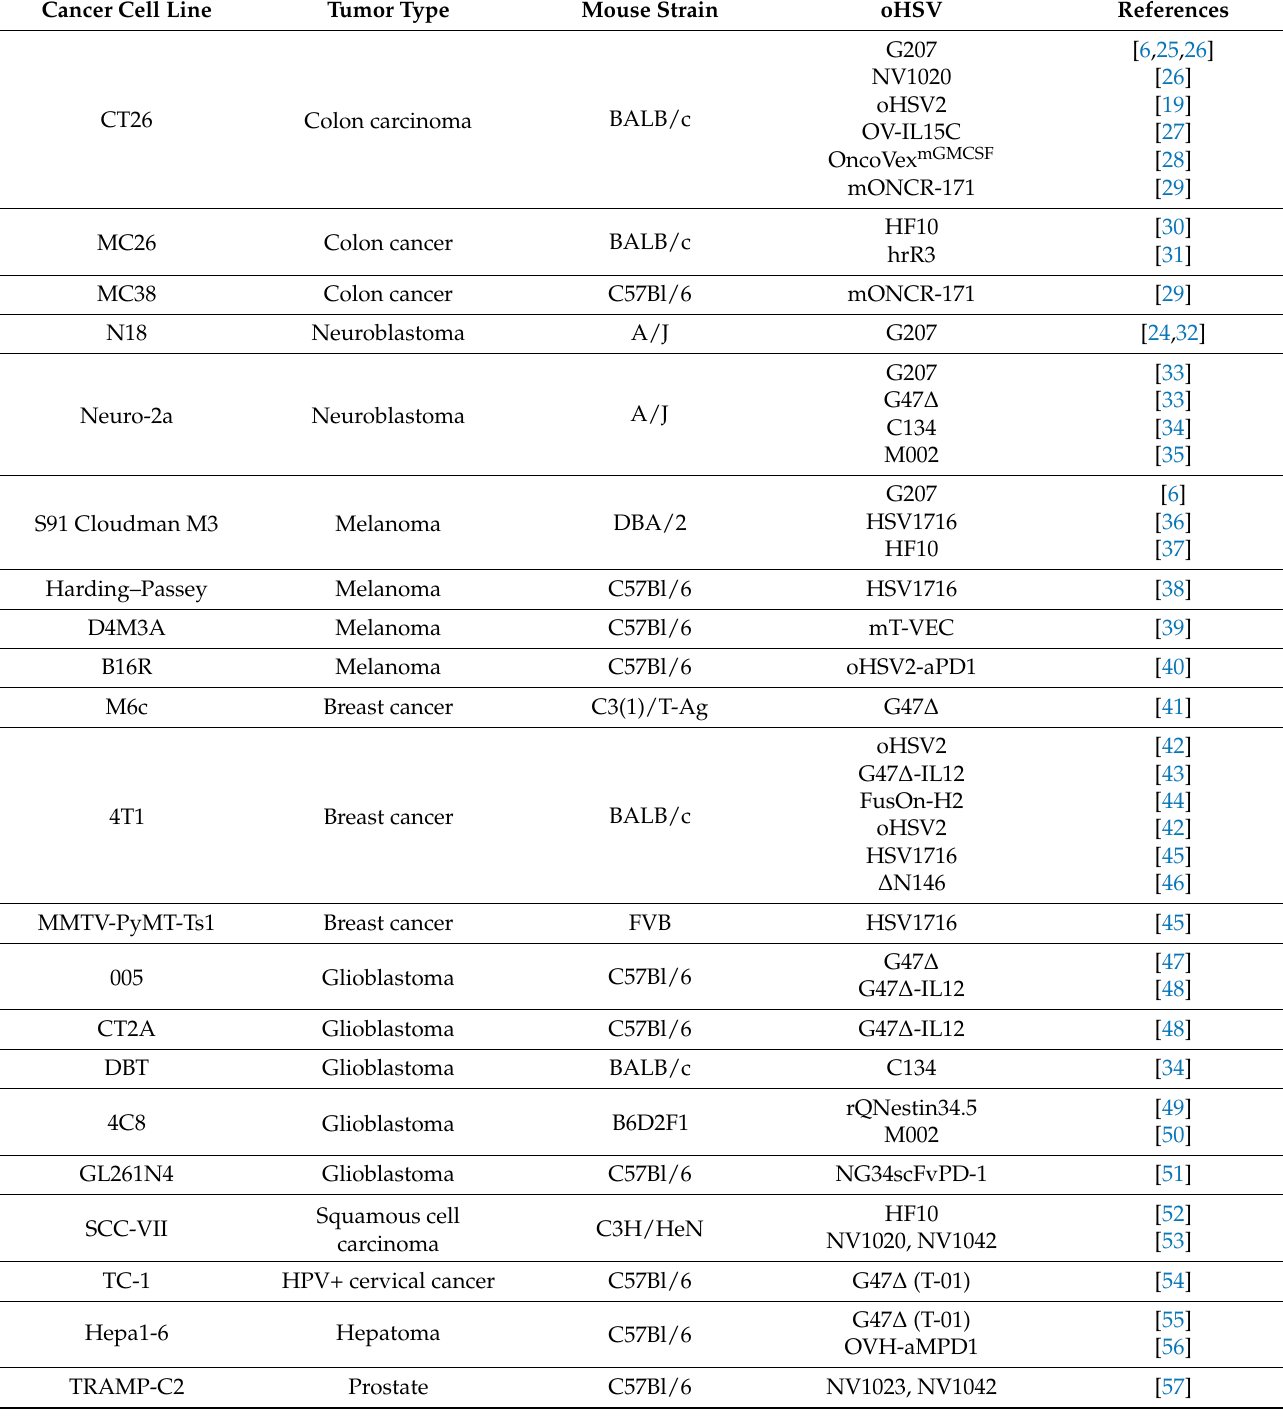
Table 1. Immunocompetent mouse cancer cell tumor models treated with